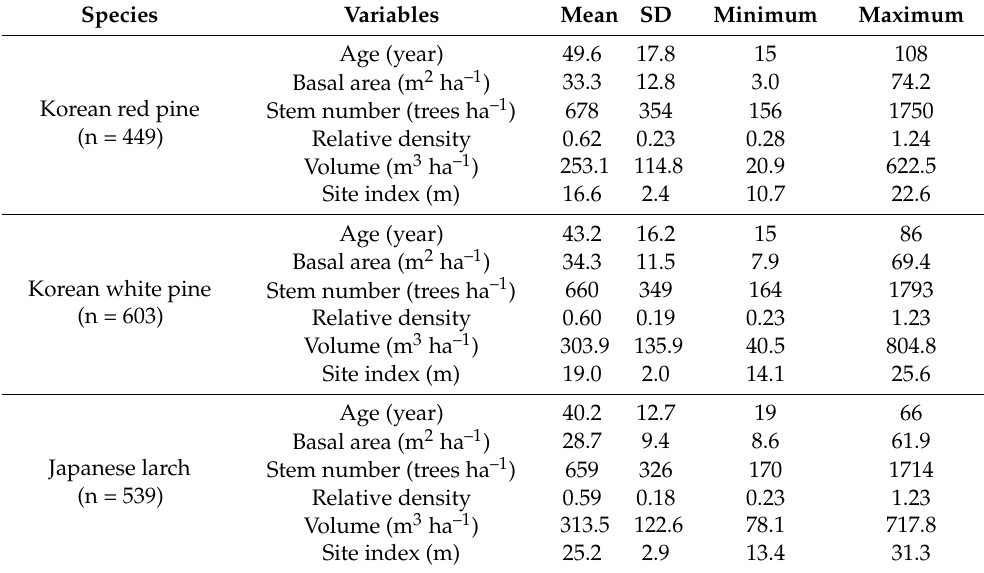
Table 2. Summary statistics of the modeling data used to develop the variable-density yield models by species. n: the number of samples. SD: standard